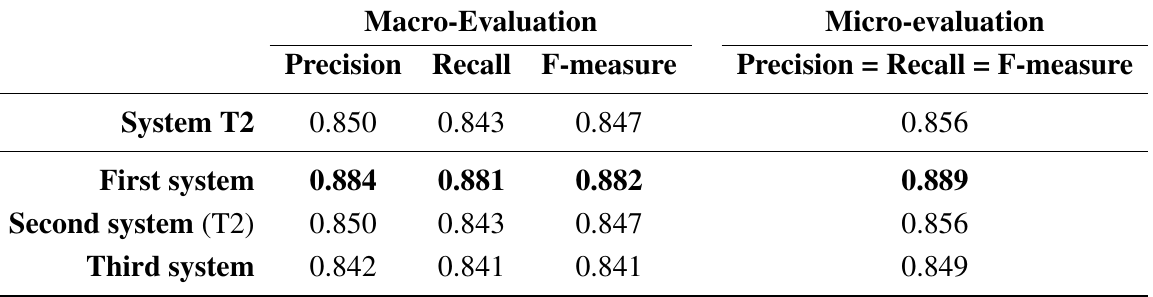
Table 13. Results obtained by system T2 on test corpus on task